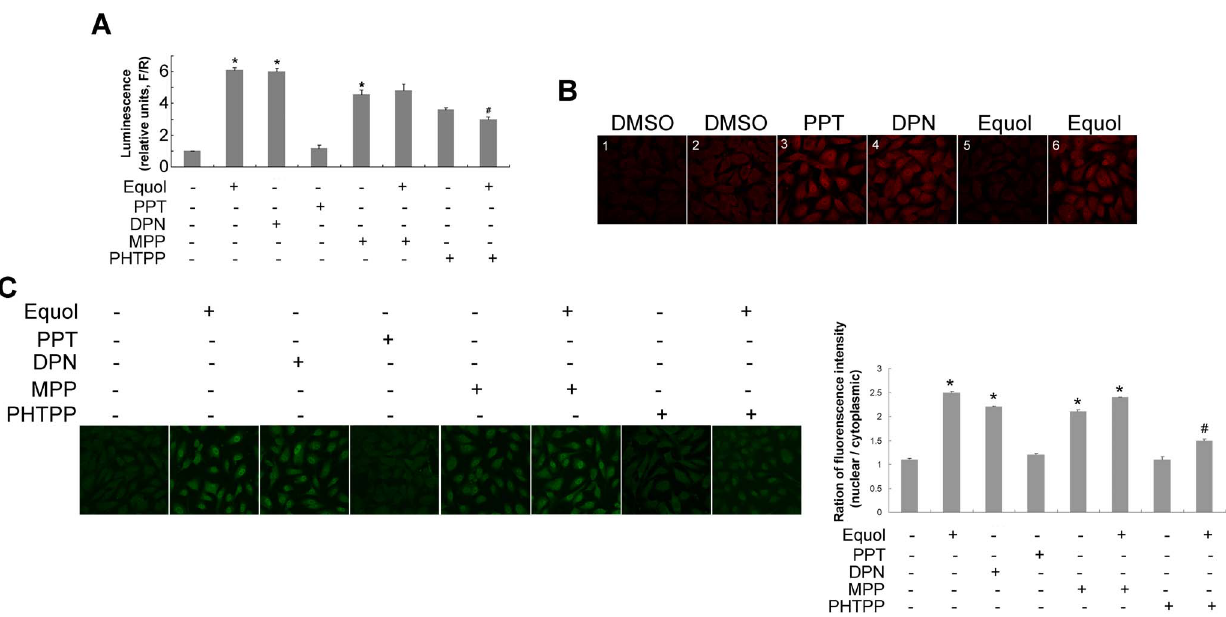
Figure 4. ER b plays a role in activation of Nrf2 by S- (-)equol in endothelial cells. (A) EA.hy926 cells were transfected with ARE-dependent firefly luciferase reporter gene ( F ) and the renilla firefly luciferase gene ( R ), and treated with 100 nM S- (-)equol in the presence or absence of 10 nM DPN, 10 nM PPT, 100 nM MPP or 100 nM PHTPP for 2 h following further incubation with or without 100 nM S- (-)equol. The potency of induction is expressed as the relative luminescence (R/F) measured using the dual luciferase reporter assay system (mean 6 SD, n=6). * p , 0.05 versus with control group, # p , 0.05 versus with S- (-)equol treated group. (B) EA.hy926 cells were incubated with 0.1% DMSO (1), 10 nM PPT (3), or 100 nM S- (- )equol (5) for 16 h and then immunostained with an antibody against ER a ; and cells also were incubated with 0.1% DMSO (2), 10 nM PPT (4), or 100 nM S- (-)equol (6) for 16 h and then immunostained with an antibody against ER b , then analyzed by confocal microscopy. (C) Cells were treated with 100 nM S- (-)equol in the presence or absence of 10 nM DPN, 10 nM PPT, 100 nM MPP or 100 nM PHTPP for 2 h following further incubation with or without 100 nM S- (-)equol, and Nrf2 localization was analyzed by confocal microscopy. Values (intensity of nuclear versus cytoplasmic) are means of counting 100 cells with standard deviations represented by vertical bars. * p , 0.05 versus with control group, # p , 0.05 versus with S- (-)equol treated group. (Figure 5E). The involvement of Nrf2 in S- (-)equol-mediated protection against oxidative stress-induced cell death was con- firmed by siRNA-induced knockdown of Nrf2. Immunoblot analysis revealed that the typical increase in Nrf2 that occurs in response to S- (-)equol did not occur in cells transfected with Nrf2- siRNA in both EA.hy926 cells and HUVECs (Figure 5F right and G right). Nrf2-siRNA transfection significantly increased cell apoptosis of control or H 2 O 2 -treated cells, indicating that Nrf2 has